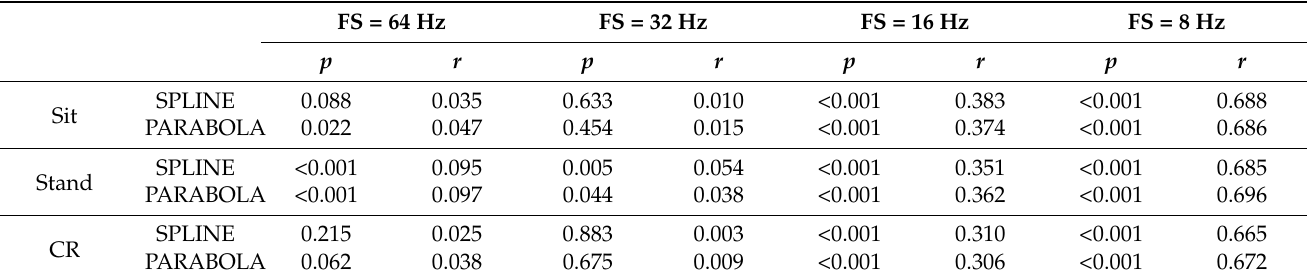
Table 7. p -value ( p ) of the Wilcoxon’s signed-rank test conducted on SPLINE vs. ORIGINAL and PARABOLA vs. ORIGINAL pairs of beat-to-beat AEs, for each PPG sampling frequency (FS) and protocol phase (in this case, ORIGINAL IBIs are derived from PPG signals sampled at 256